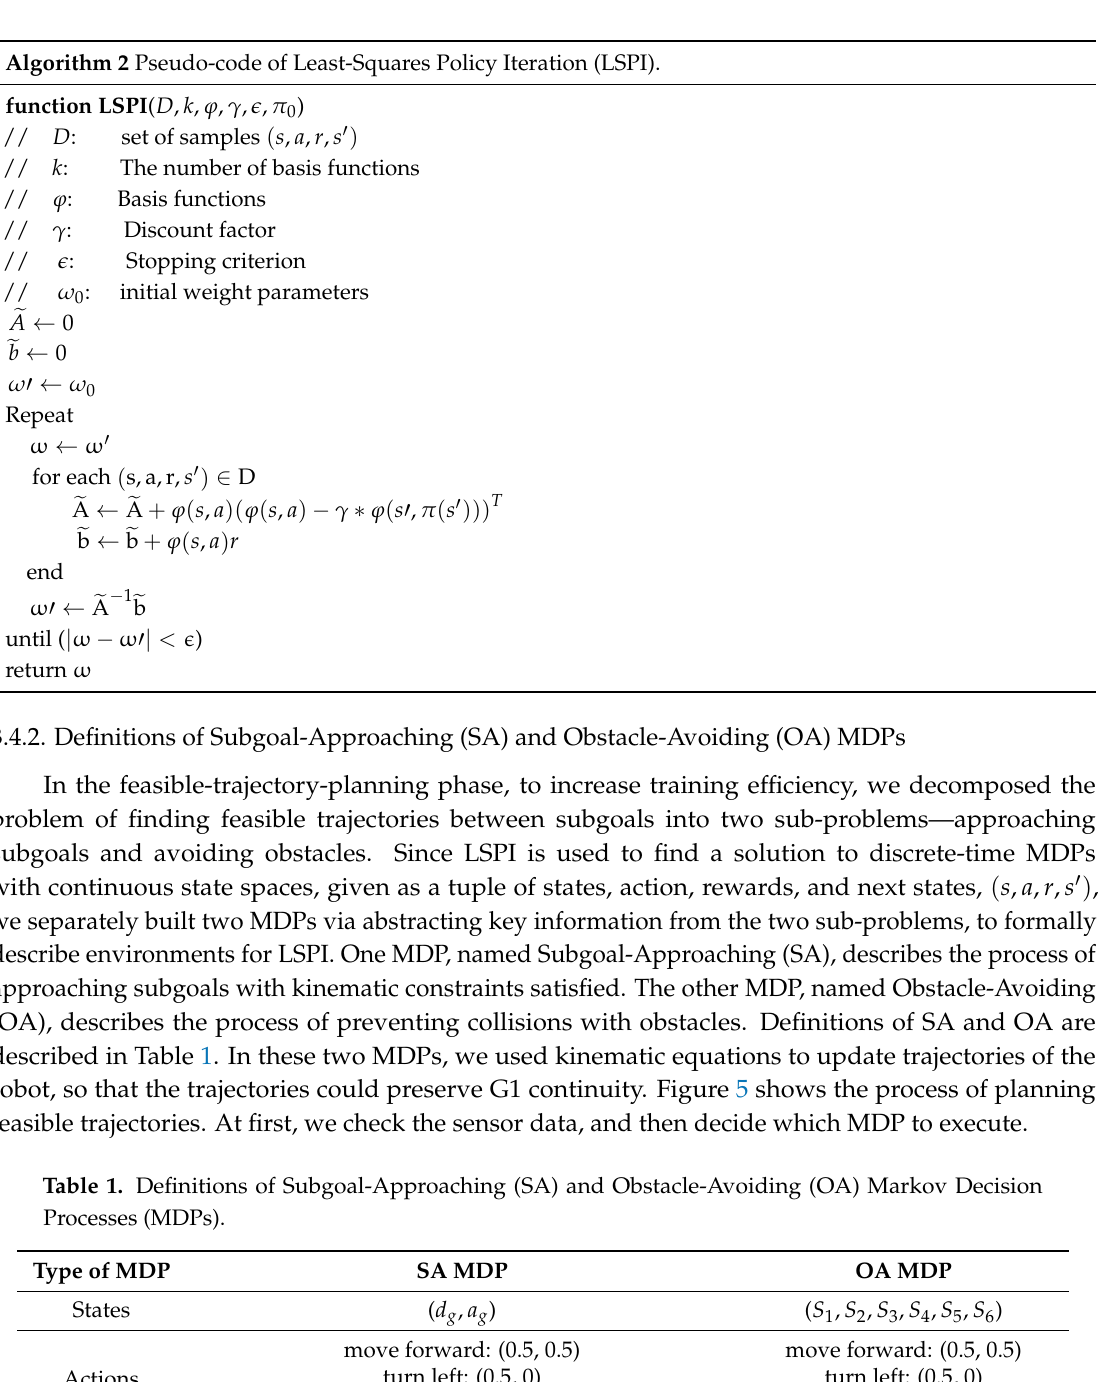
Table 4, where P = 0.9 − (cid:101) a